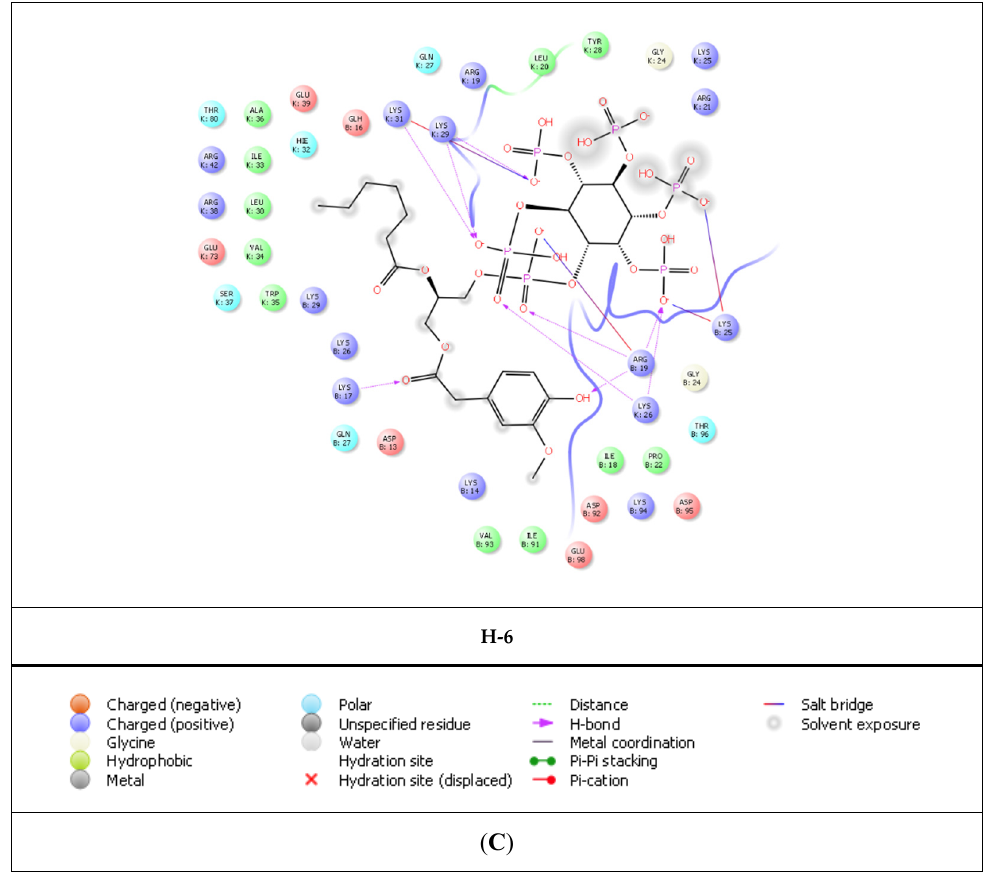
Figure 8. Docking poses of nine new superimposed L ‐ HIPPO derivatives (yellow dashes: hydrogen bonding) in the MA domain (PDB ID: 7E1I). ( A ) Surface presentation. ( B ) Ribbon presentation). ( C ) Docking interactions of H ‐ 2 and H ‐ 6 in the MA domain (PDB ID: 7E1I). Table 3. Docking score (kcal/mol), glide gscore (kcal/mol), and glide emodel (kcal/mol) results of aromatic group ‐ based nine new L ‐ HIPPO derivatives in the MA domain (PDB IDs: 7E1I, 7E1J, and 7E1K).